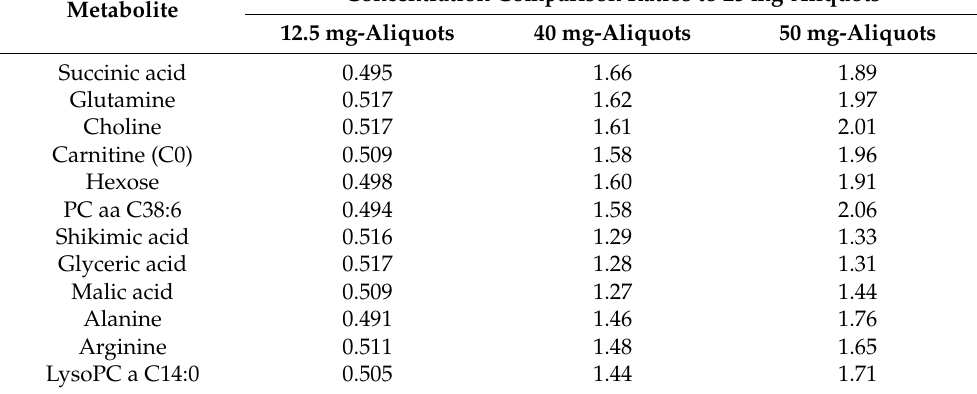
Table 1. Comparison of Ratios of Selected Metabolites Extracted from Three Different Quantities of Pine Needle SRM to a 25 mg Extract. Concentration Comparison Ratios to 25 Metabolite